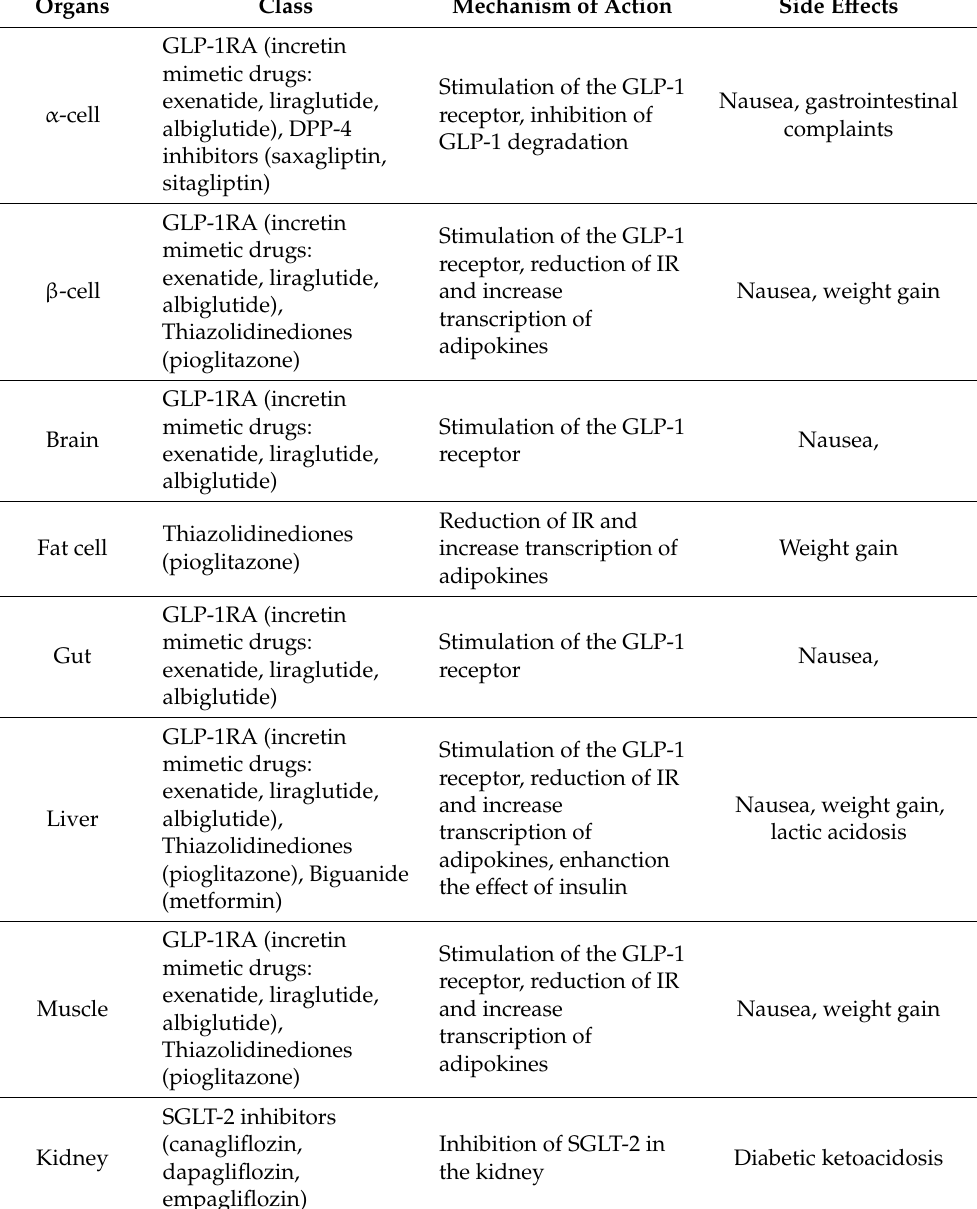
Table 1. The pathophysiological defects of organs were targeted by various classes of available hypoglycemic